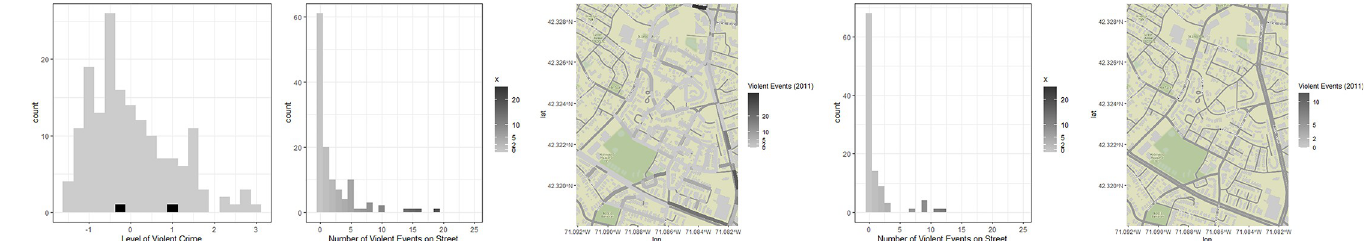
Fig 1. The variation in crime exposure within and between neighborhoods. (a) The distribution of the level of violent crime for all census tracts with student residents, highlighting two neighborhoods, one with below-average the other with above-average violent crime. Below is a direct comparison of the distribution of violent events across the streets of the two neighborhoods (b, d; above-average crime neighborhood on top) and corresponding maps (c, e). Note that scales for numbers of crimes ( x -axis and coloration) were kept consistent between the two tracts to enable easier comparison.